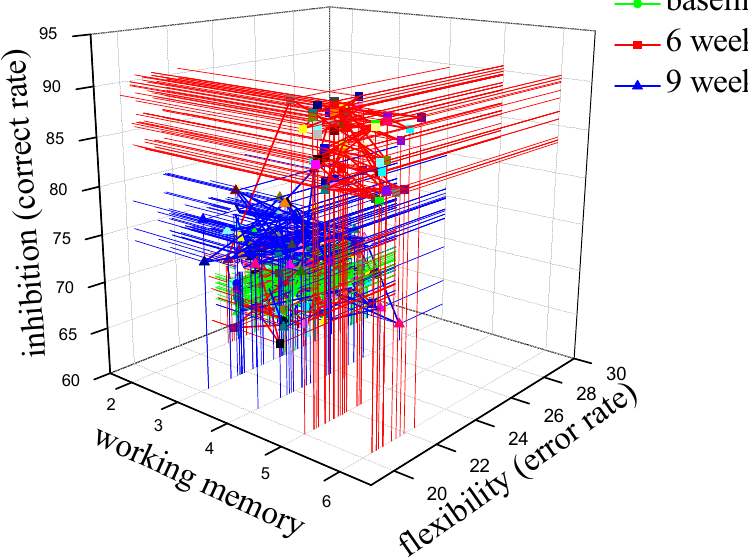
Figure 4. Changes in the three core functions of executive